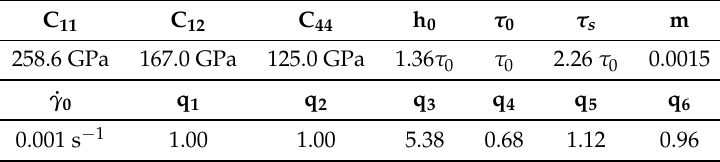
Table 2. Parameters of the CP model for MAR-M247. The elastic constants were obtained from [43], while the values that define the expression (10) were fitted from the experimental data in the parallel